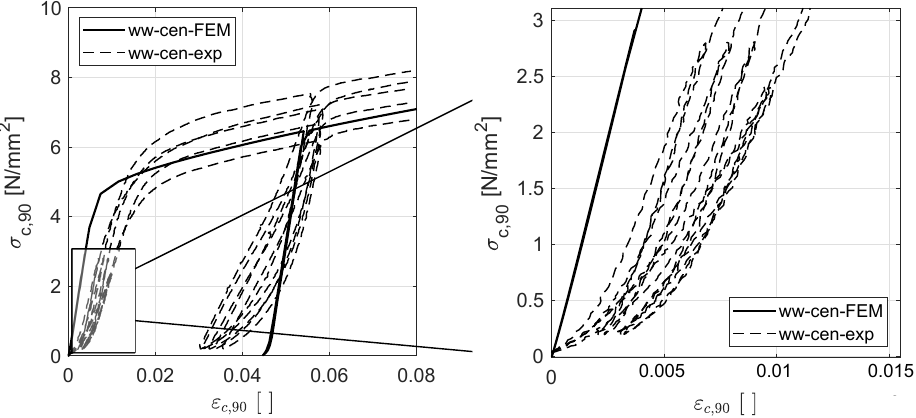
Figure 4. Compression stress vs. strain curves for W100-F140-cen-ww from FEM and experiment with unloading and reloading